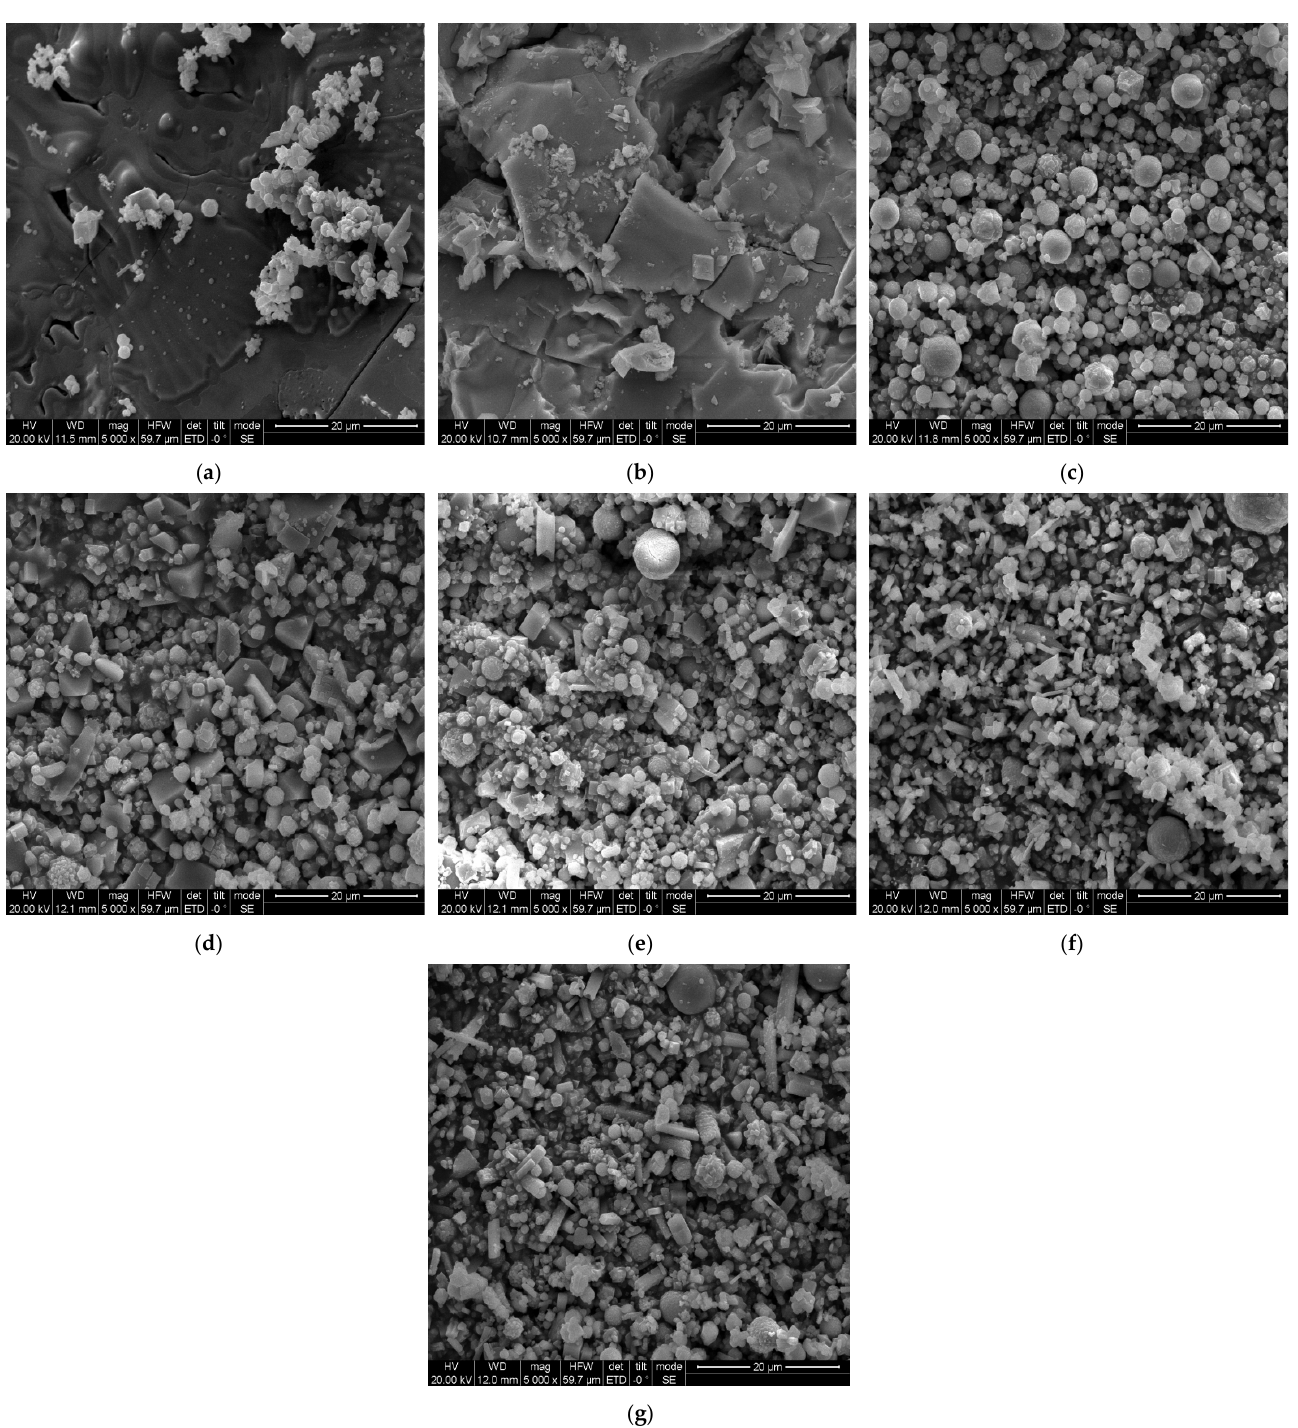
Figure 2. SEM of initial microstructure of raw materials. ( a ) SEM diagram of pure PTFE powder; ( b ) SEM diagram of pure TiH 2 powder; ( c ) SEM diagram of pure Al powder; ( d ) SEM diagram of Al/TiH 2 powder; ( e ) SEM diagram of PTFE/TiH 2 powder; ( f ) SEM diagram of Al/PTFE powder; ( g ) SEM diagram of Al/TFE/TiH 2 powder.